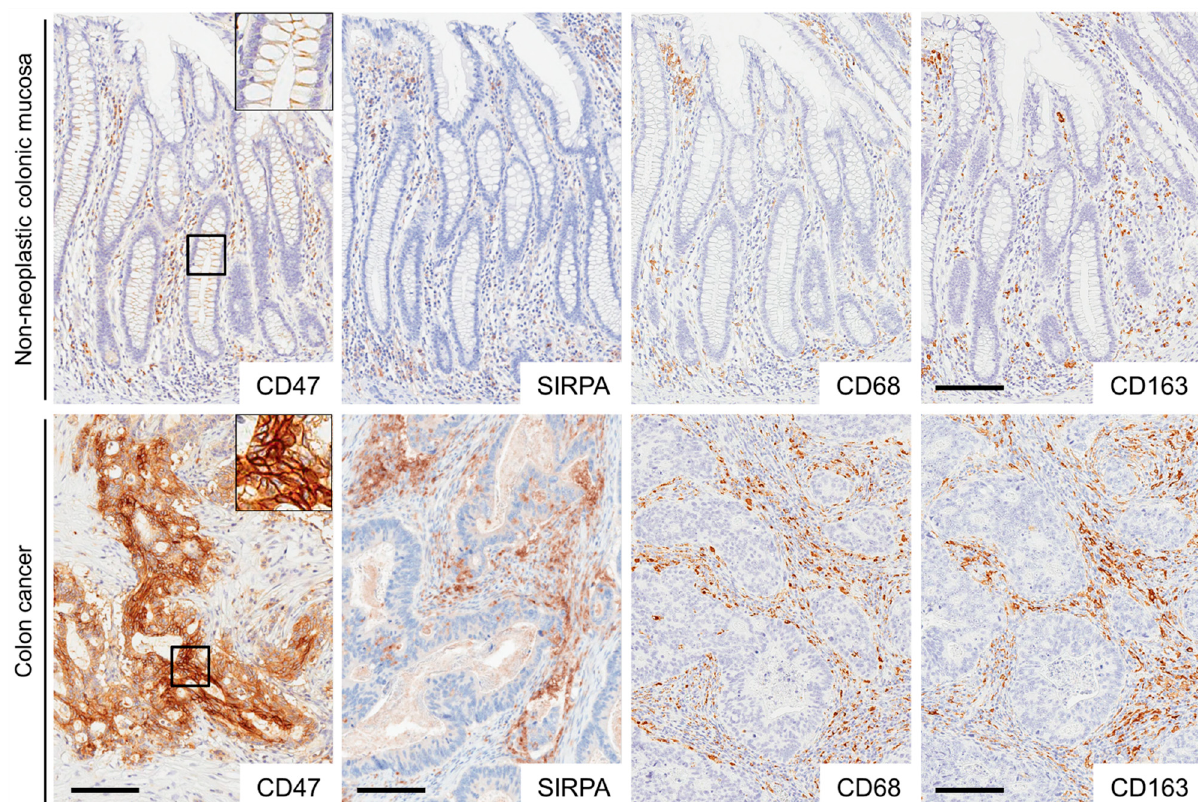
Figure 1. Representative images of CD47, SIRPA, CD68, and CD163 immunostaining in non-neoplastic colonic mucosae and colorectal cancer (CRC) tissues. CD47 was weakly expressed on the cytomembrane of non-neoplastic colonic epithelial cells. CRC cells expressed CD47 on the cytomembrane. Non-neoplastic colonic mucosae and colon cancer stroma contained immune cells positive for signal regulatory protein-alpha (SIRPA), CD68, or CD163. Bar, 100 μ m.